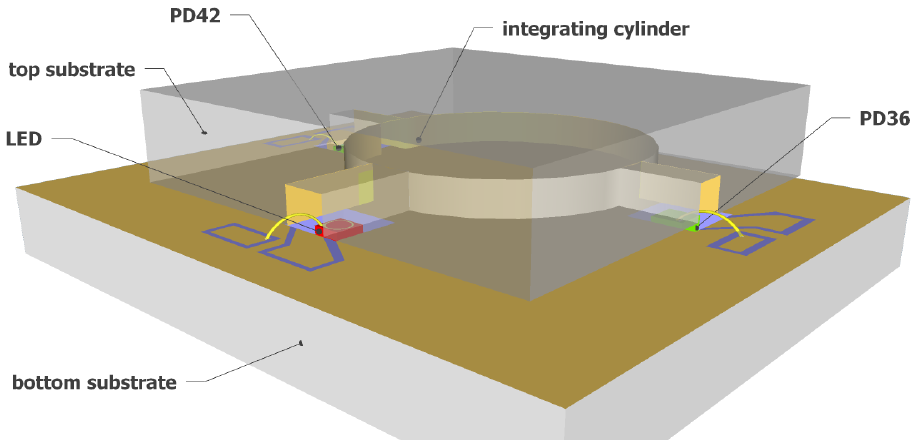
Figure 2. Schematic of the fully integrated on-chip NDIR CO 2 sensor. The sensor uses an integrating cylinder as sensing cavity, a mid-IR LED as the optical source, and two mid-IR photodiodes (PD42 and PD36) as optical